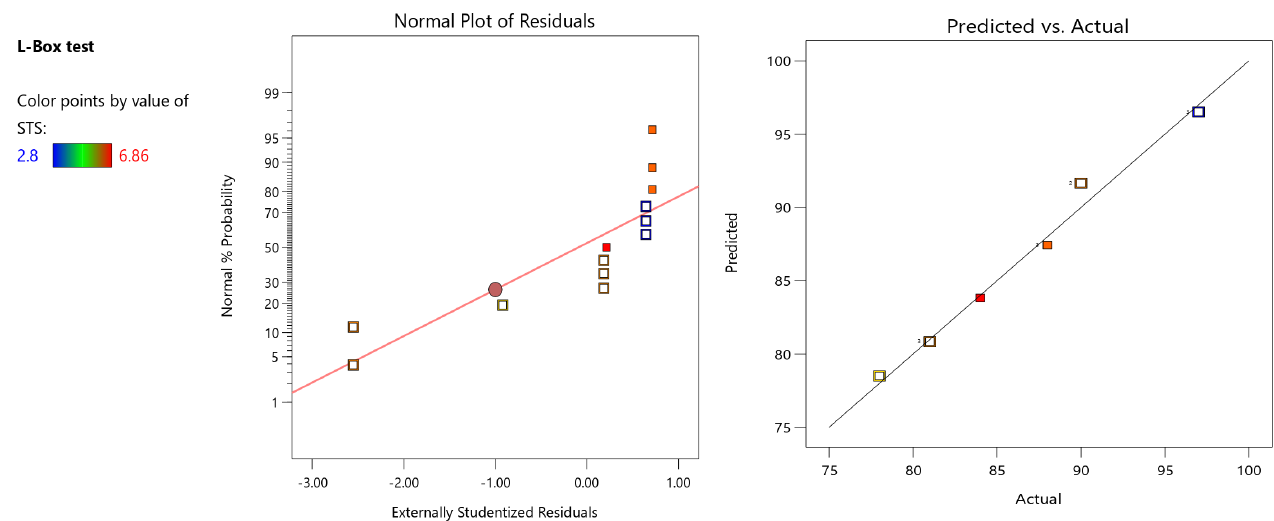
Figure 14. Normal plot for residuals, and actual vs. predicted values for L-Box test.